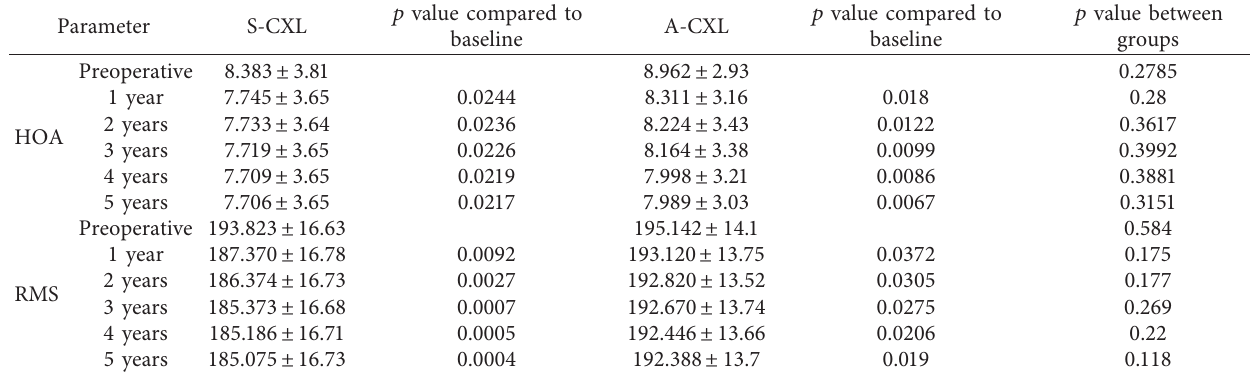
Table 4: Abberometric parameter evolution in both